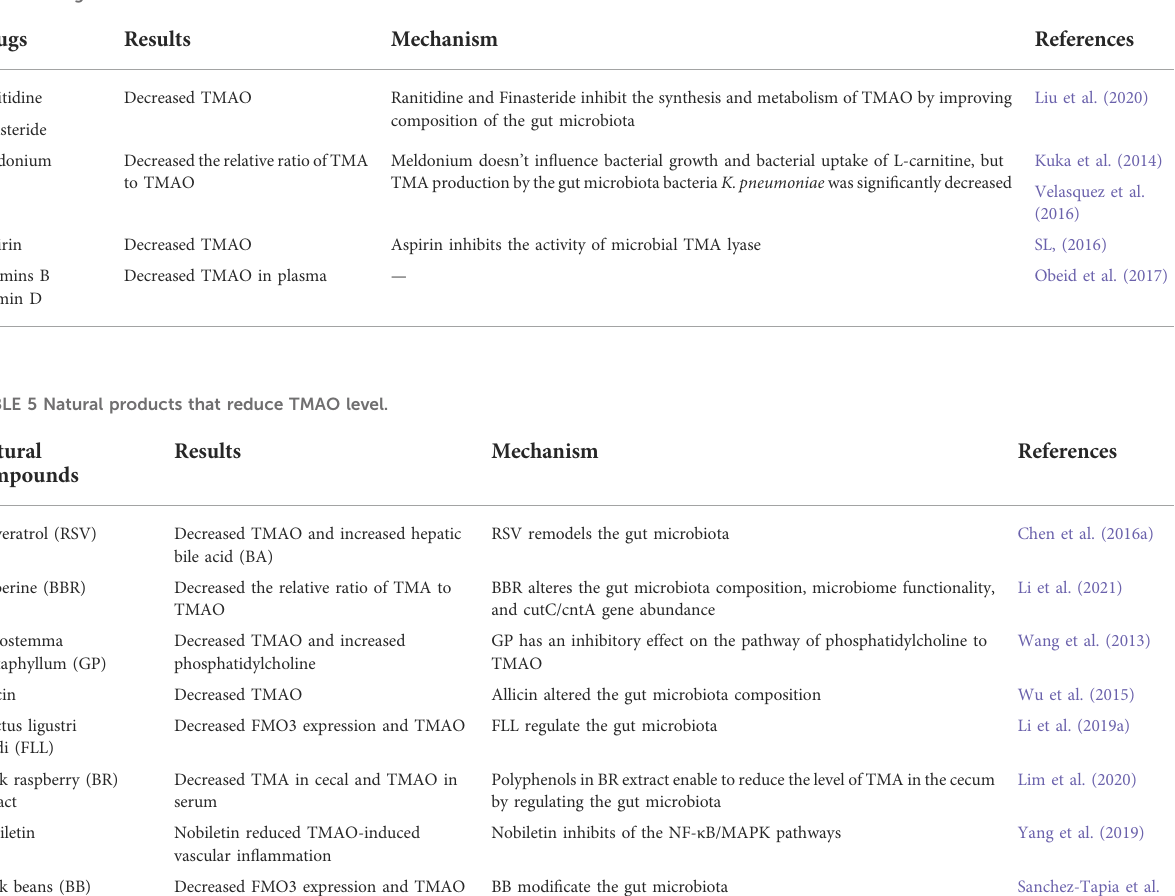
TABLE 4 Drugs that reduce TMAO level.